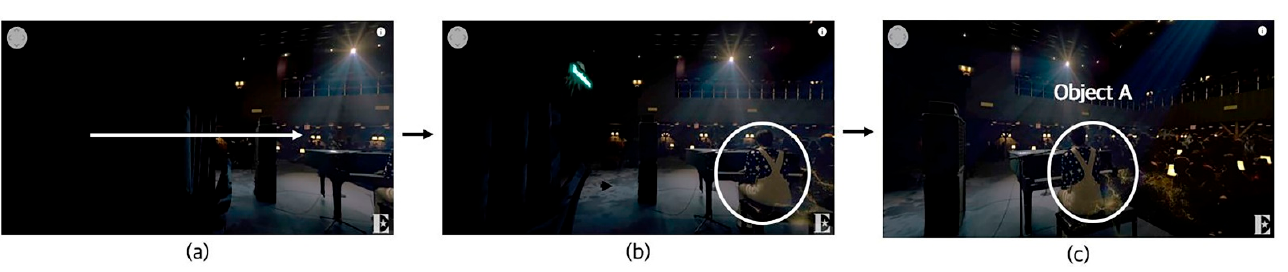
Figure 6. Directed Case 1 using “camera movement” (video No. 23). ( a ) The camera moves in the direction of the marked arrow, ( b ) The user's attention moves to the right along the camera's movement, ( c ) The user can see the scene where object A plays the piano in the location intended by the director.